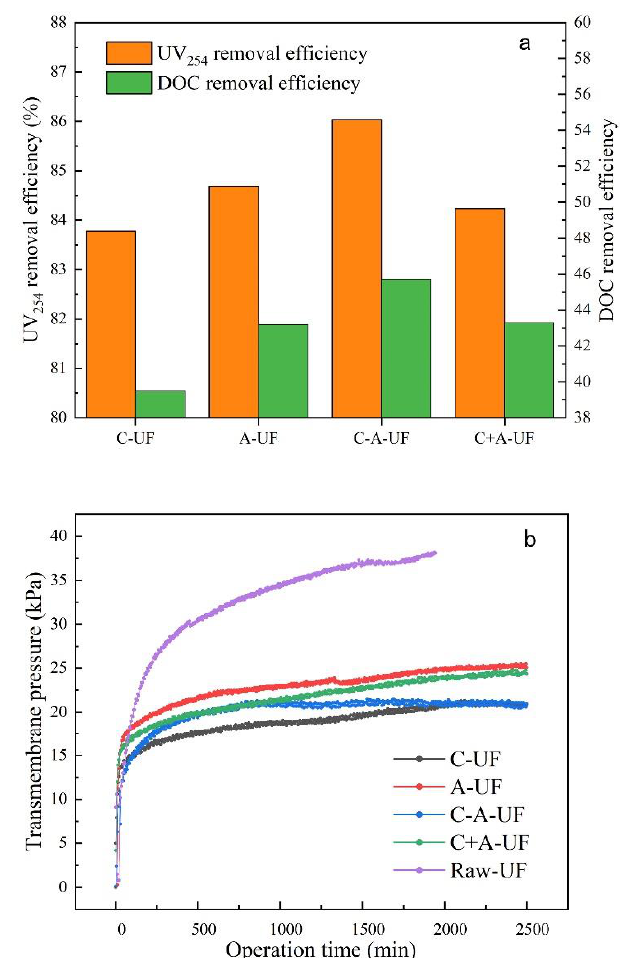
Figure 4. The effect of different pre-treatments for ultra-filtration effluent ( a ) and transmembrane pressure (TMP) ( b ).